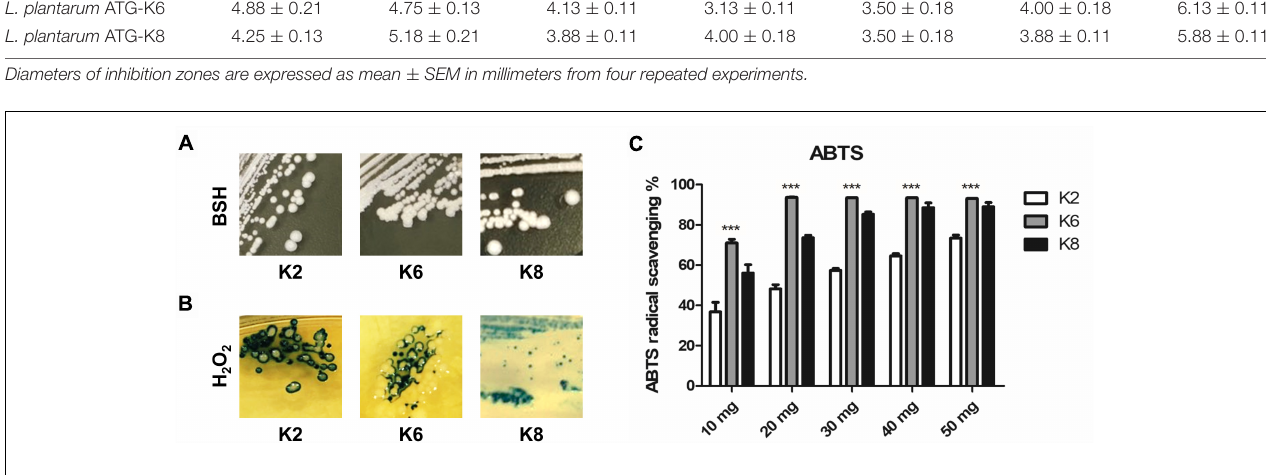
replicate experiments as the error bars indicate. Except for